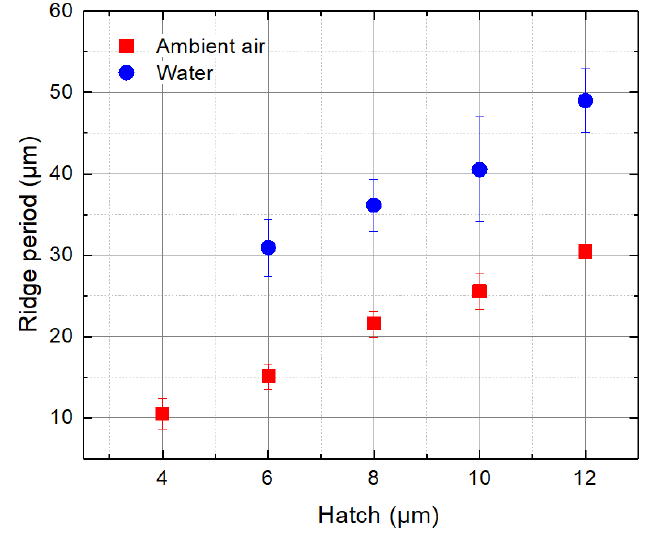
Figure 9. The period of ridges versus the hatch distance.